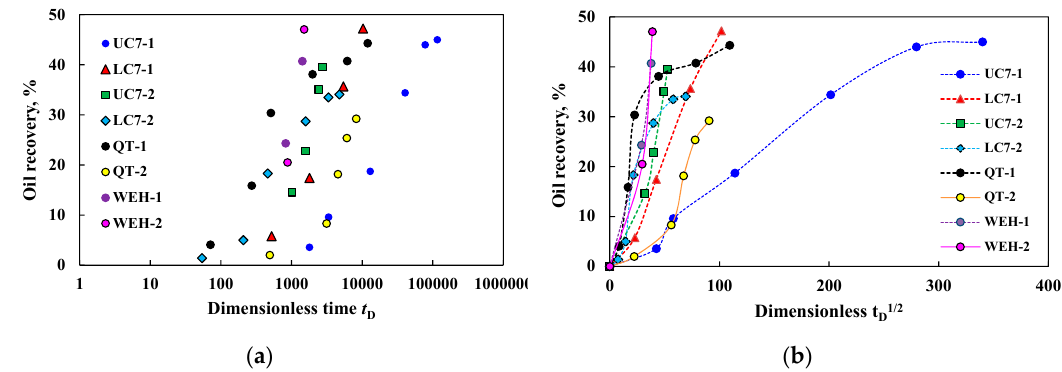
Figure 18. The oil recovery vs dimensionless time t D and t D0.5 : ( a ) oil recovery vs t D and ( b ) oil recovery vs t D0.5 . vs t D0.5 .